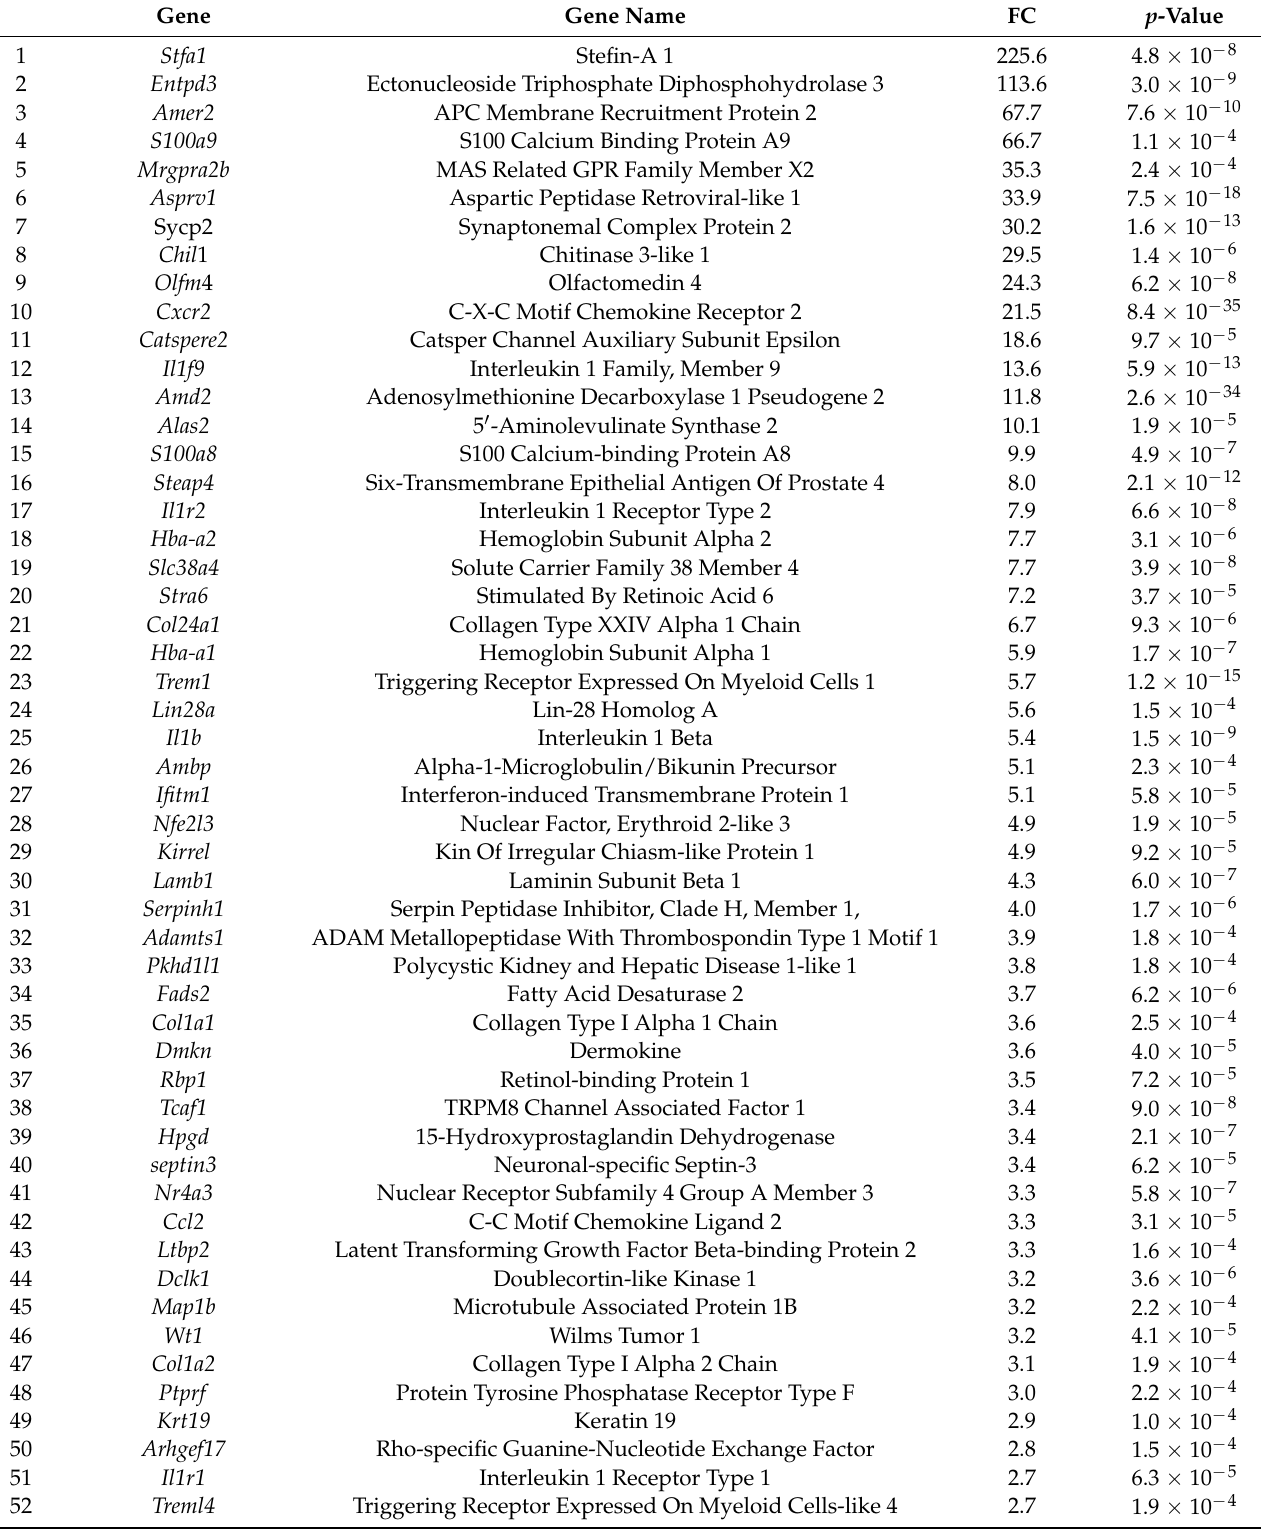
Table 1. Differentially expressed genes of MAC-FOXO3 82 in FOXO3-deficient mouse macrophages relative to control ( n = 3, FC ≥ |1.5|, p <